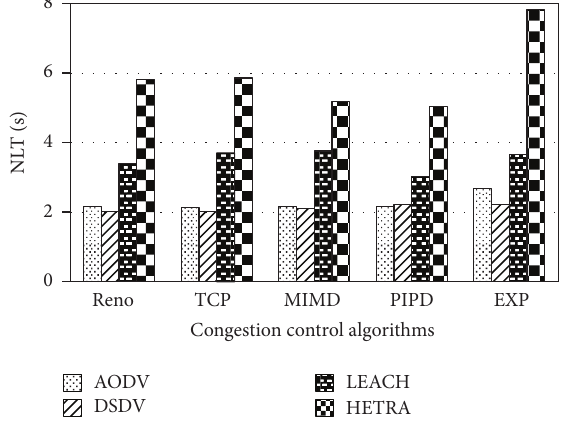
Figure 7: NLT for Pattern